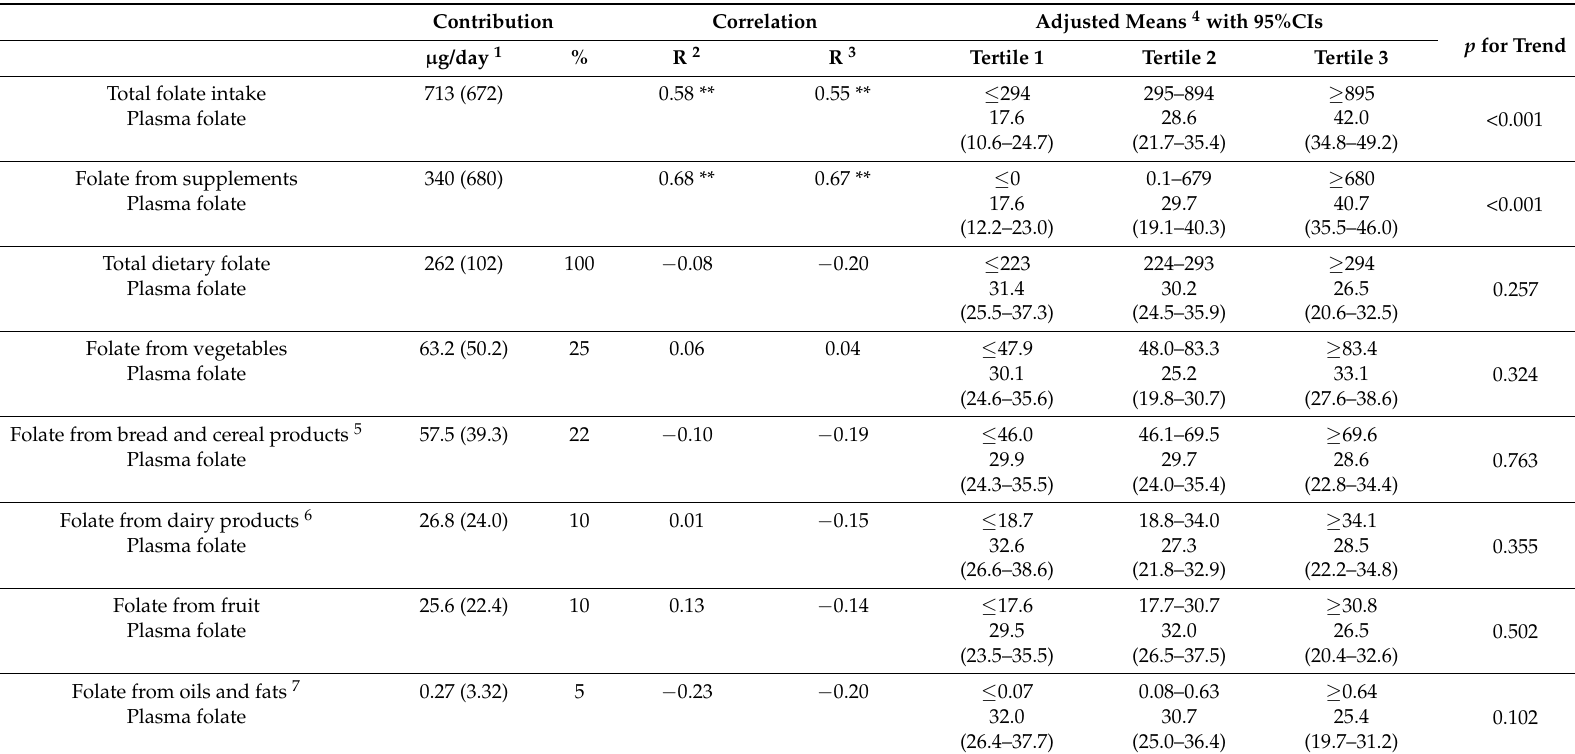
Table 2. Absolute ( µ g/day) and relative (%) contribution of dietary sources to total dietary folate intake, Spearman’s rank and partial correlation coefficients (R) between folate intake and plasma folate levels, and adjusted means with 95% confidence intervals for plasma folate levels (nmol/L) according to tertiles of folate intake ( µ g/day) among Dutch women with a pregnancy wish ( n =